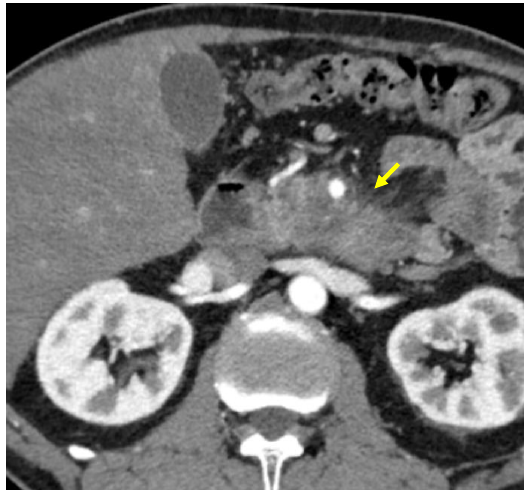
Figure 4. Pancreatic lesion with ill-defined margins (arrow) on CT examination in pancreatic contrast phase.